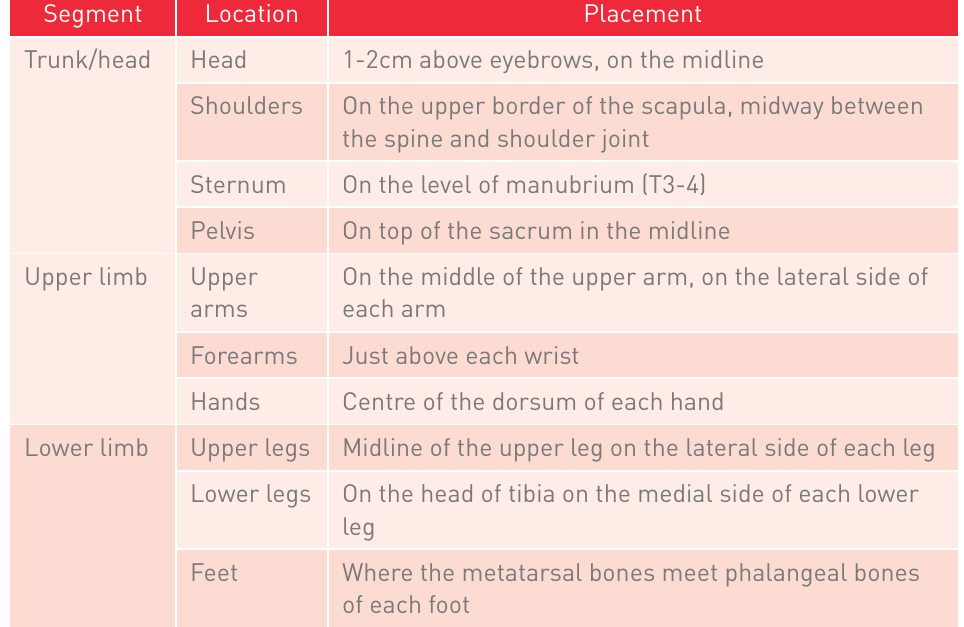
Placement and fixing of sensors